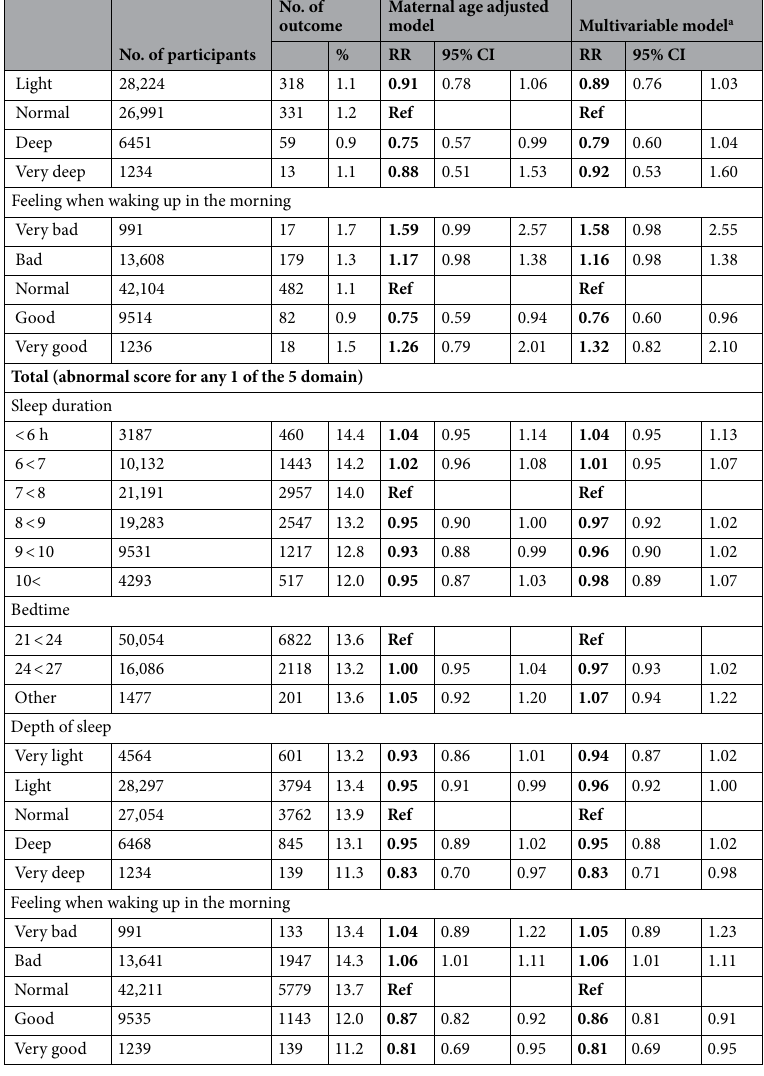
Table 5. Association between sleep during pregnancy and infant development, Japan Environment and Children’s Study (2011–2014). CI confidence interval, RR risk ratio. Bold fonts showed the items of the Ages and Stages Questionnaire. a Adjusted for maternal age at delivery, smoking habits, alcohol consumption, pre- pregnancy body mass index, gestational age at birth, parity, infertility treatment, and infant